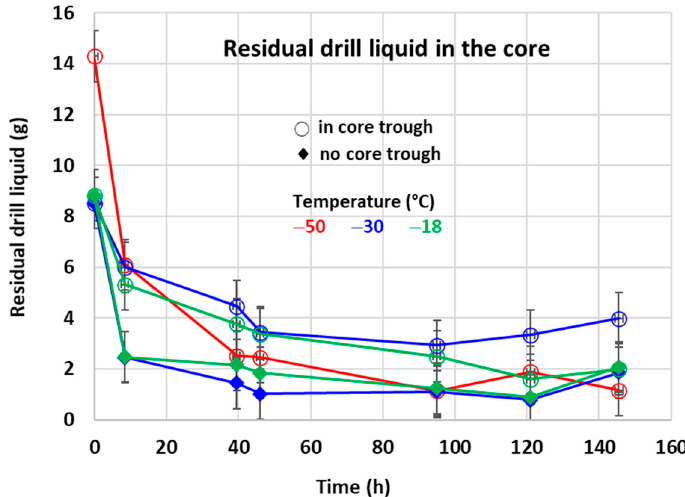
Figure 4. Amount of drilling liquid in the ice cores as a function of time.